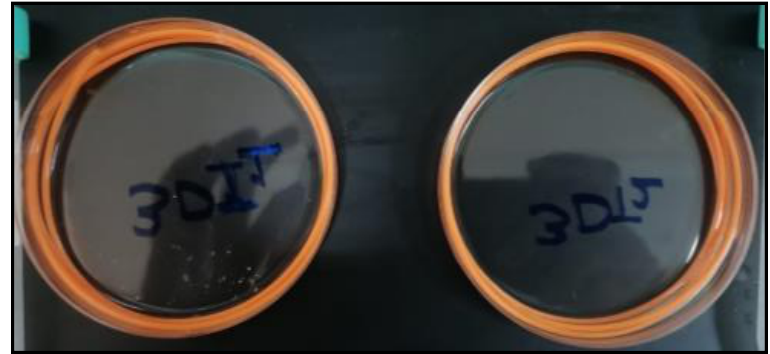
Figure 4. Encapsulation of BAB in the PLA unprocessed filament (3DP1 and 3DP2).